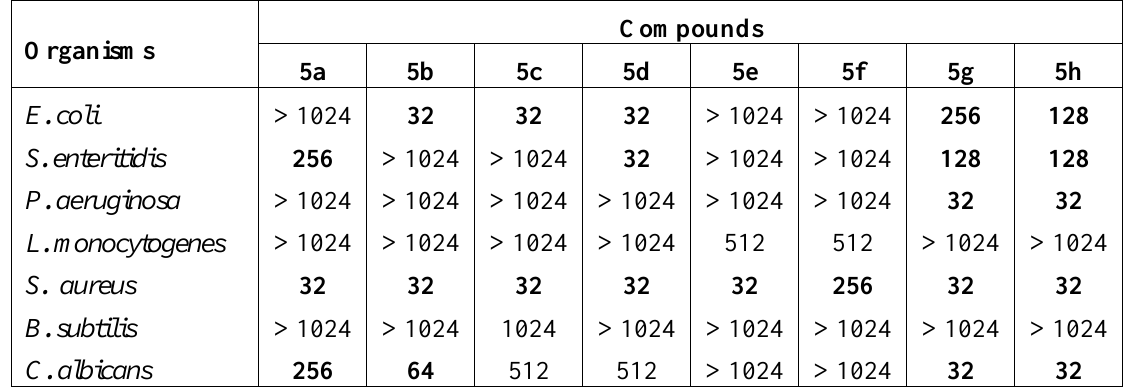
Table 6. The quantitative antibacterial and antifungal activity test results of the new thioureides and the respective MIC values.